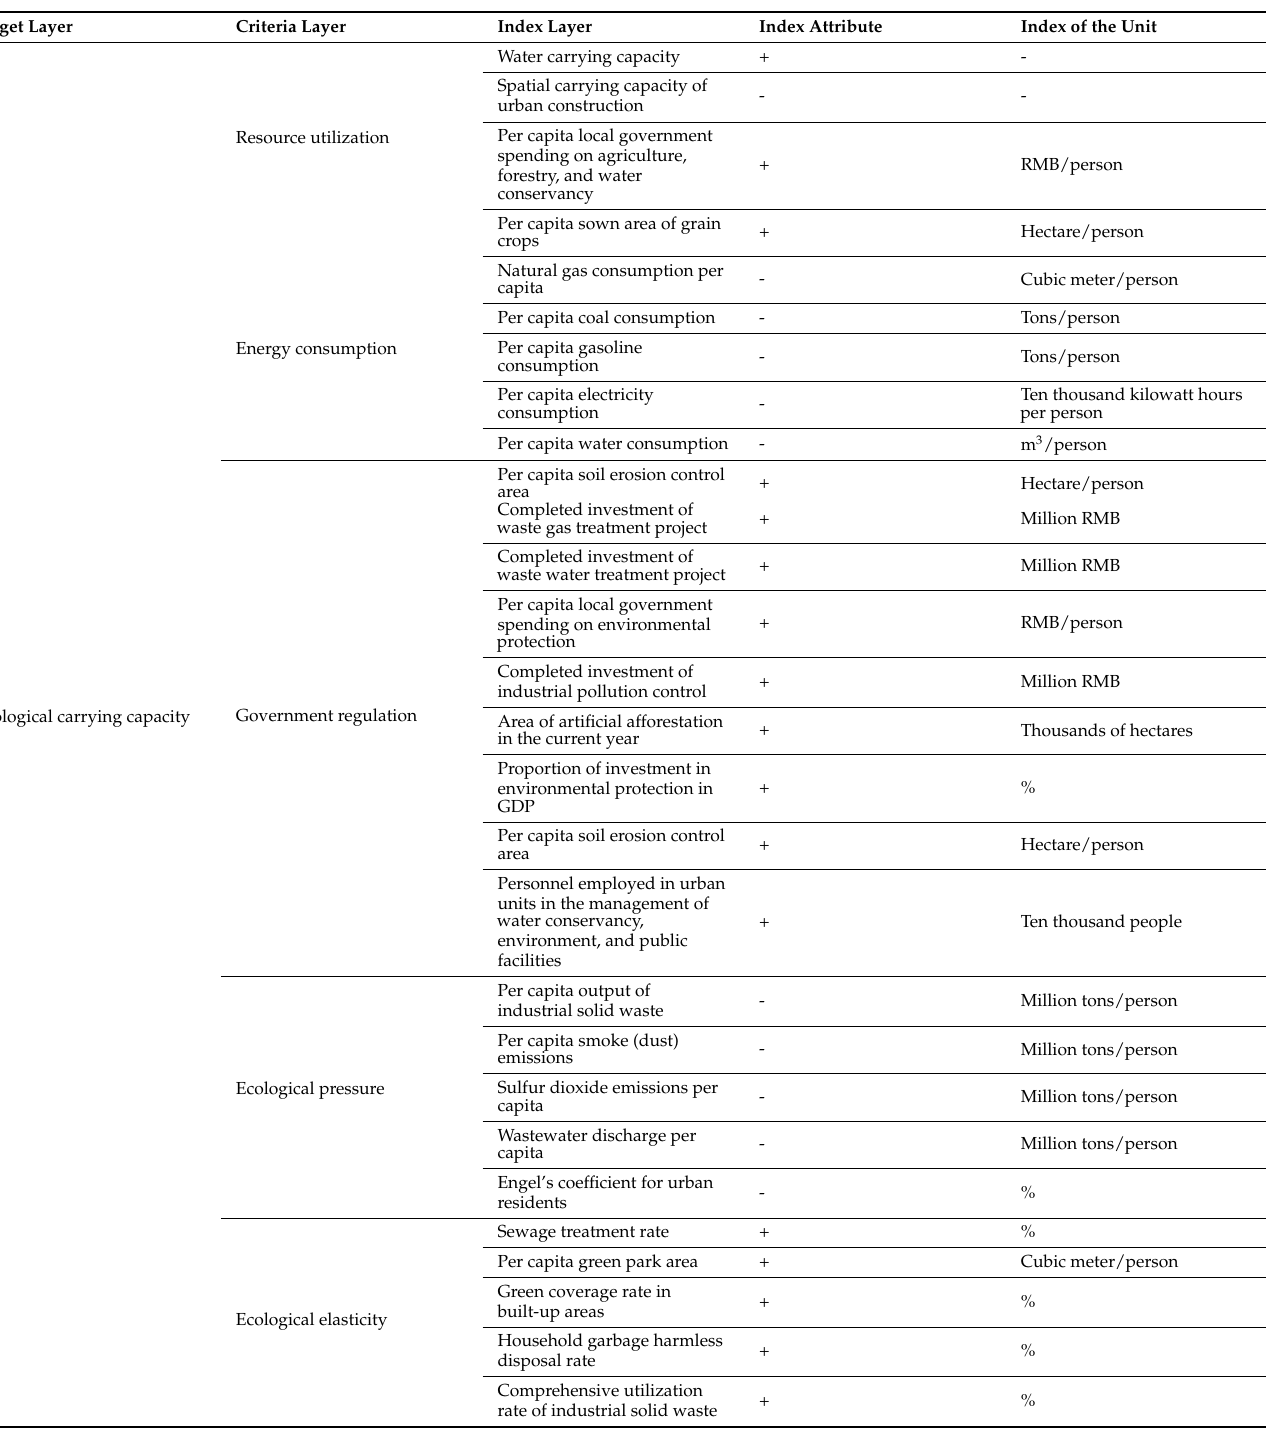
Table 2. Index system of ecological carrying